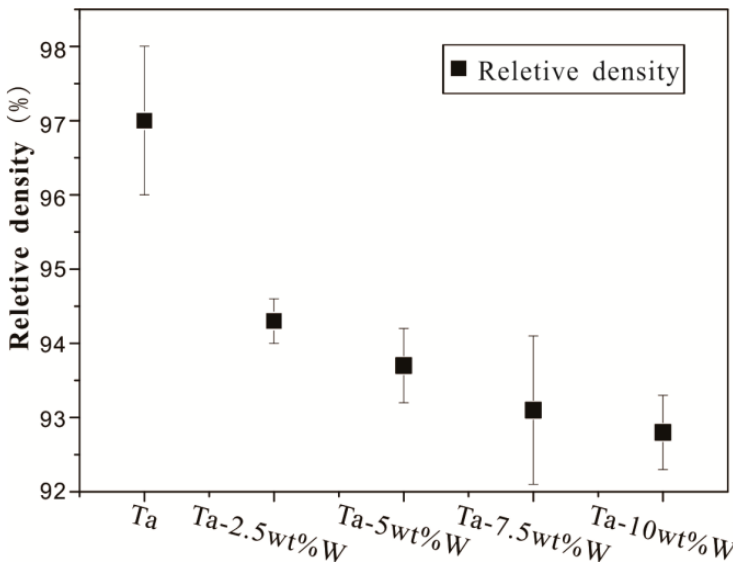
Figure 2. The relative density varies with the content of tungsten (wt%).